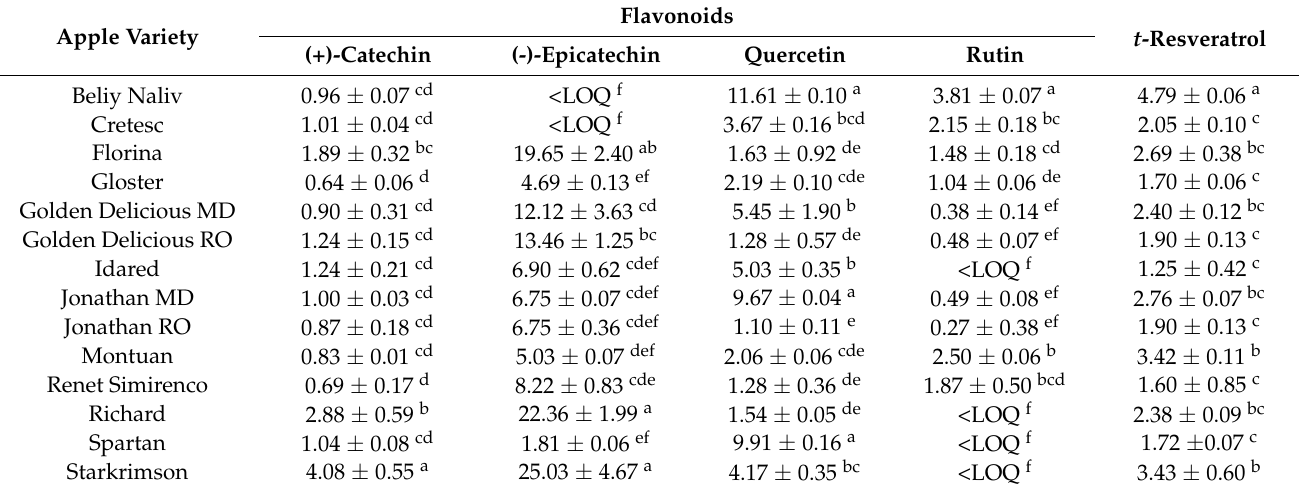
Table 2. Concentration (mg/100 g dry weight (DW)) of flavonoids and t -resveratrol in different apple cultivars. Apple Variety